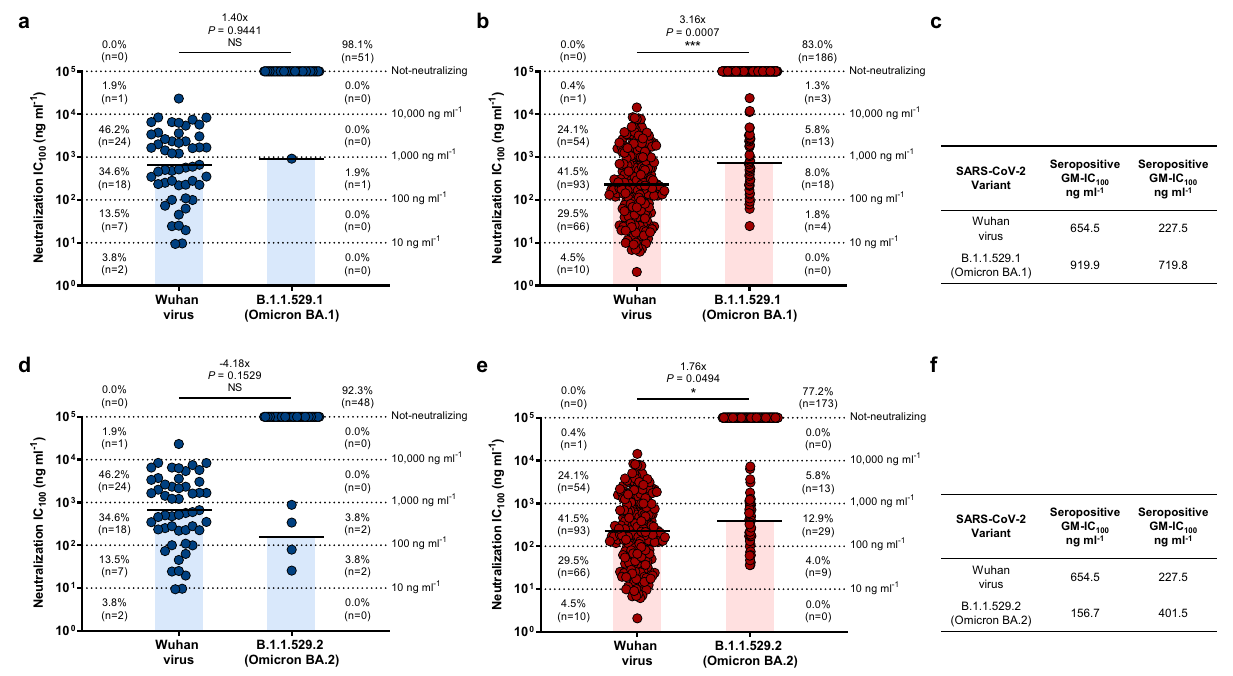
Fig. 1 Functional characterization of Omicron BA.1 and BA.2 nAbs. a – f Dot charts show the neutralization potency, reported as IC 100 (ng ml − 1 ), of nAbs tested against the original SARS-CoV-2 virus fi rst detected in Wuhan, the BA.1 and BA.2 Omicron VoC for seronegatives ( a , c , d , f ) and seropositives ( b , c , e , f ). The number and percentage of nAbs from individuals who were seronegative versus seropositive, fold change, neutralization IC 100 geometric mean (black lines, blue and red bars) and statistical signi fi cance are denoted on each graph. Technical duplicates were performed for each experiment. A non-parametric Mann – Whitney t -test was used to evaluate statistical signi fi cances between groups. Two-tailed P value signi fi cances are shown as * P < 0.05, ** P < 0.01, *** P < 0.001. NS, not signi fi cant. c , f Tables show the IC 100 geometric mean (GM) of all nAbs pulled together from each group against Wuhan, BA.1 ( c ) and BA.2 ( f )